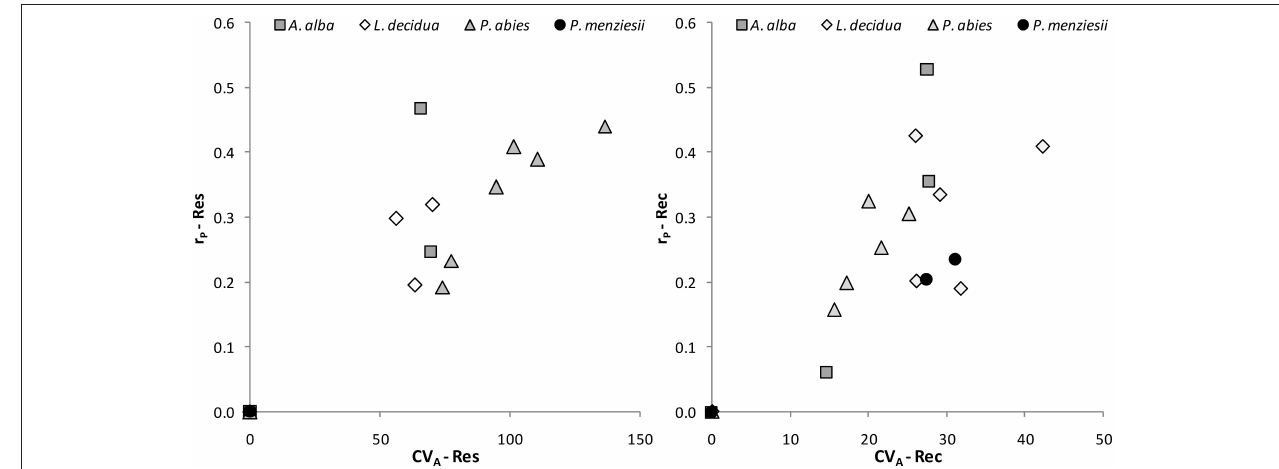
FIGURE 6 | Evolvability of drought response of individual provenances as given by the coefficient of additive genetic variation CV A and the degree of genetic determination, i.e., the repeatability r P for resistance (Res) and recovery (Rec).